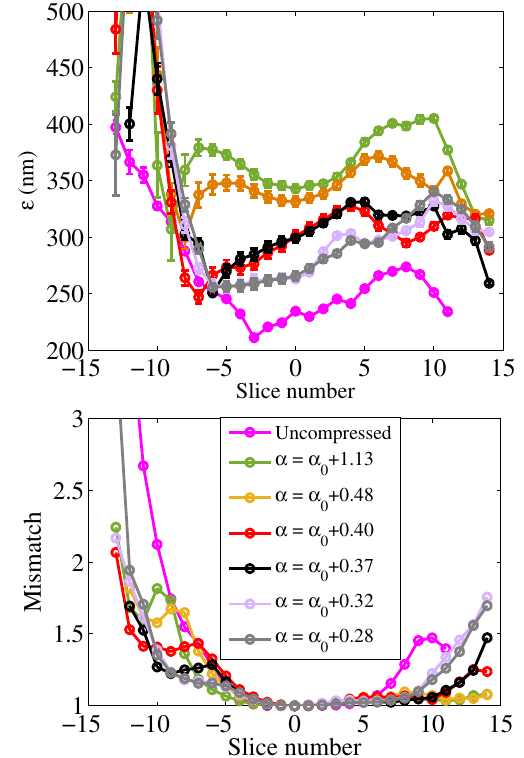
FIG. 7. Measured horizontal slice emittance (top) and mismatch with respect to the core (bottom) along the bunch for different beam optics settings along the bunch compressor. The compres- sion factor is 8. The inset in the lower plot lists the horizontal α at the entrance of the bunch compressor. These optics are expected to be similar to the ones shown in Fig. 15, but not the same because of some other small adjustments during the optimization.